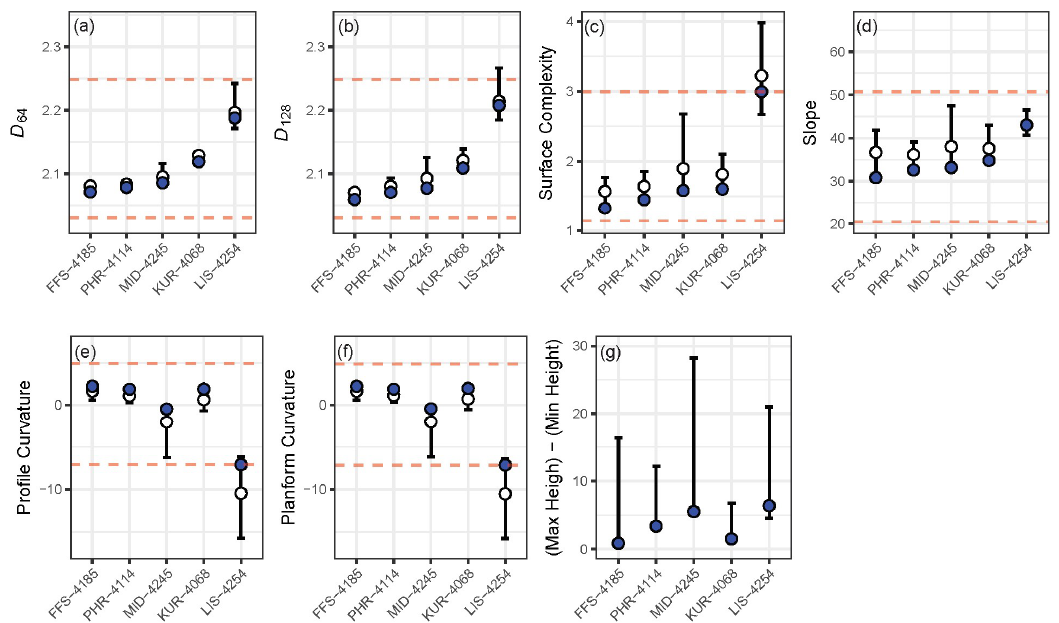
Figure 4. Habitat metrics calculated in R from five randomly chosen sites, showing ( a ) D 64 , ( b ) D 128 , ( c ) 3D surface complexity, ( d ) slope, ( e ) profile curvature and ( f ) planform curvature. The 3D models were haphazardly tilted in six different ways, generating six DEMs for each site. Habitat metrics were then calculated from each DEM. The blue circles show values before tilting. The bars show minimum and maximum values from the seven DEMs (one before titling and six tilted), with white circles showing the mean values. Red dotted lines show minimum and maximum values from the 85 sites, without tilting. Differences in the maximum heights and minimum heights, (Max Height)–(Min Height), of the DEMs are also shown ( g ) in reference to the extent of model tilting used in this post-hoc analysis.